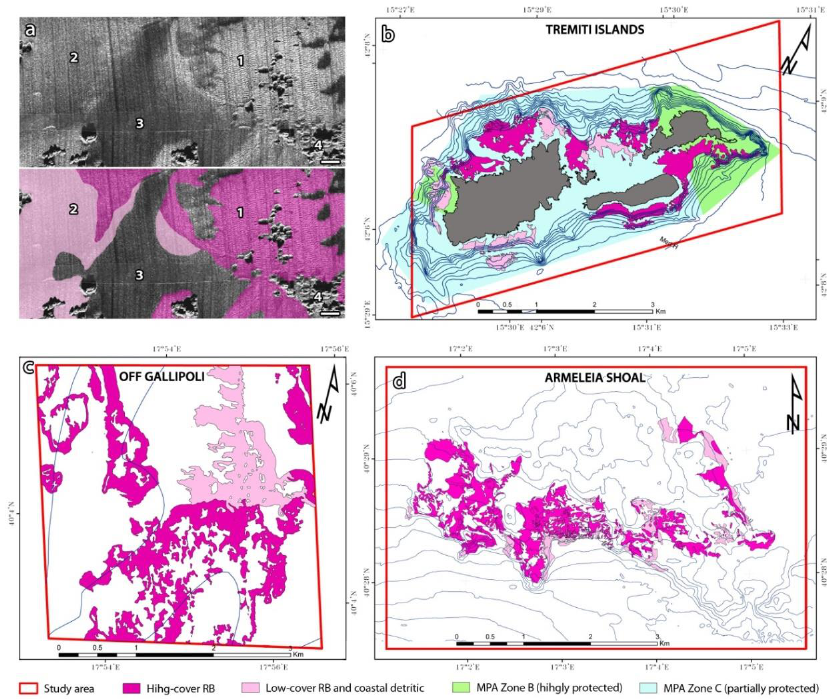
Figure 2. Mapping of rhodolith beds (RBs): ( a ) Example of backscatter at Armeleia shoal and habitat interpretation, with: high-cover RB (1) in an area characterized by mega-ripples, low-cover RB and coastal detritic (2), muddy-detritic bottom (3), and coralligenous bioconstructions (4) (scale bar 10 m); ( b ) RB at Tremiti Islands, with indication of the Marine Protected Area (MPA) zonation; ( c ) RB off Gallipoli; ( d ) RB at Armeleia Shoal.